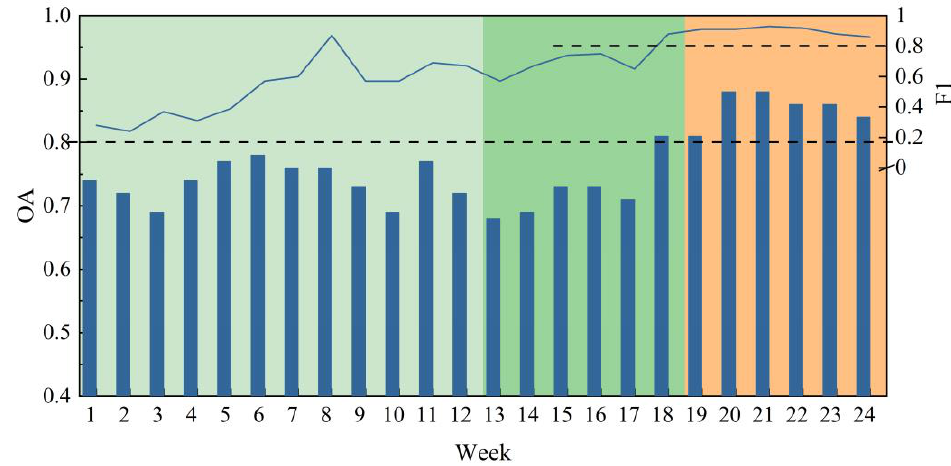
Figure 11. Extraction results of single remote sensing image, where overall accuracy (OA) is a histogram, and F1 score(F1) is a line graph. The X-axis represent research span of time (a total of 24 weeks).